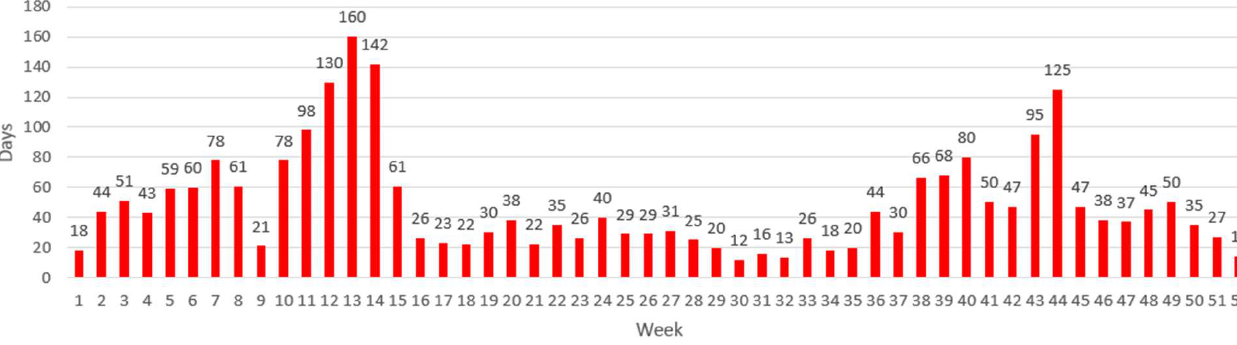
Figure 1. Weekly absences for company 1 in 2020, showing an increase from week 11, which was the beginning of the COVID-19 pandemic in Belgium. This increase continued for 4 weeks during the first COVID wave. A second peak started from week 43, which could have been partly due to another wave of infections at the workplace.